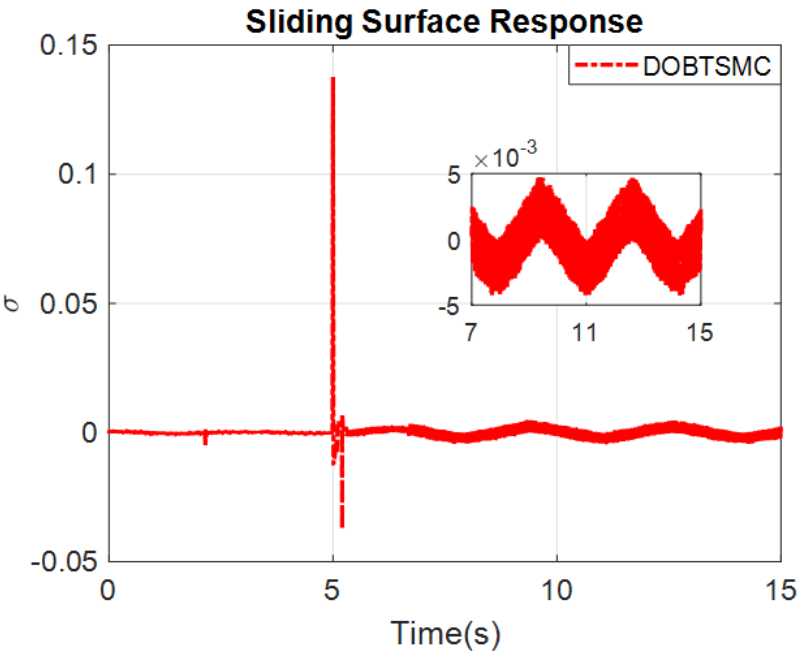
Figure 5. Sliding surface response of the proposed control algorithm.